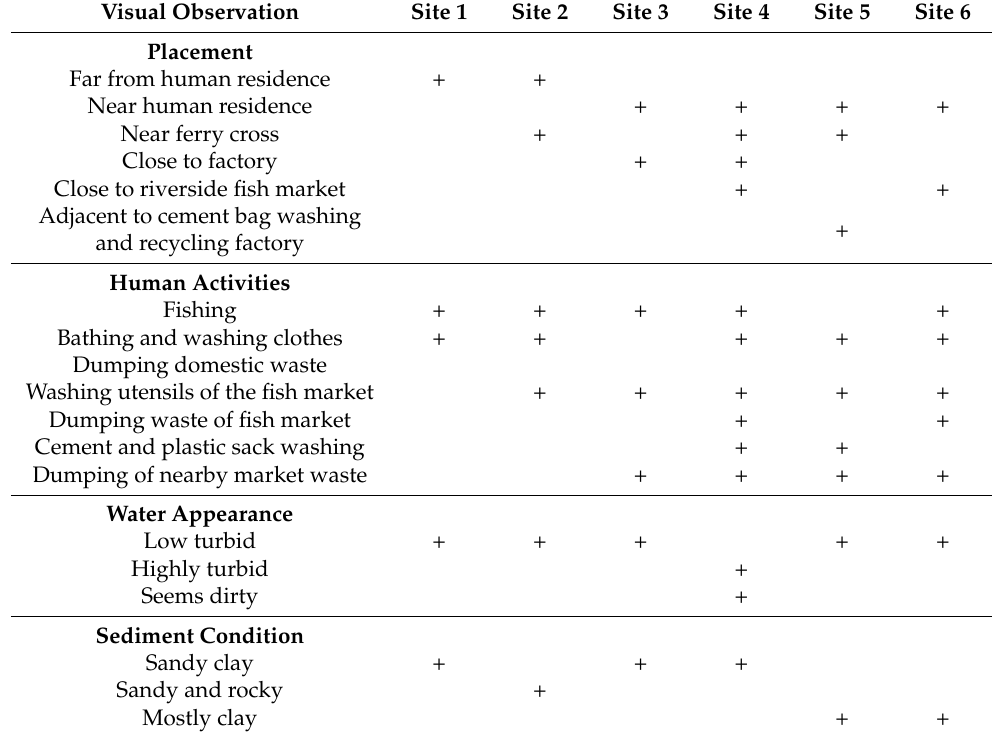
Table 1. Physical and infrastructural observation of sampling sites (+ indicates ‘yes’ sign). Visual